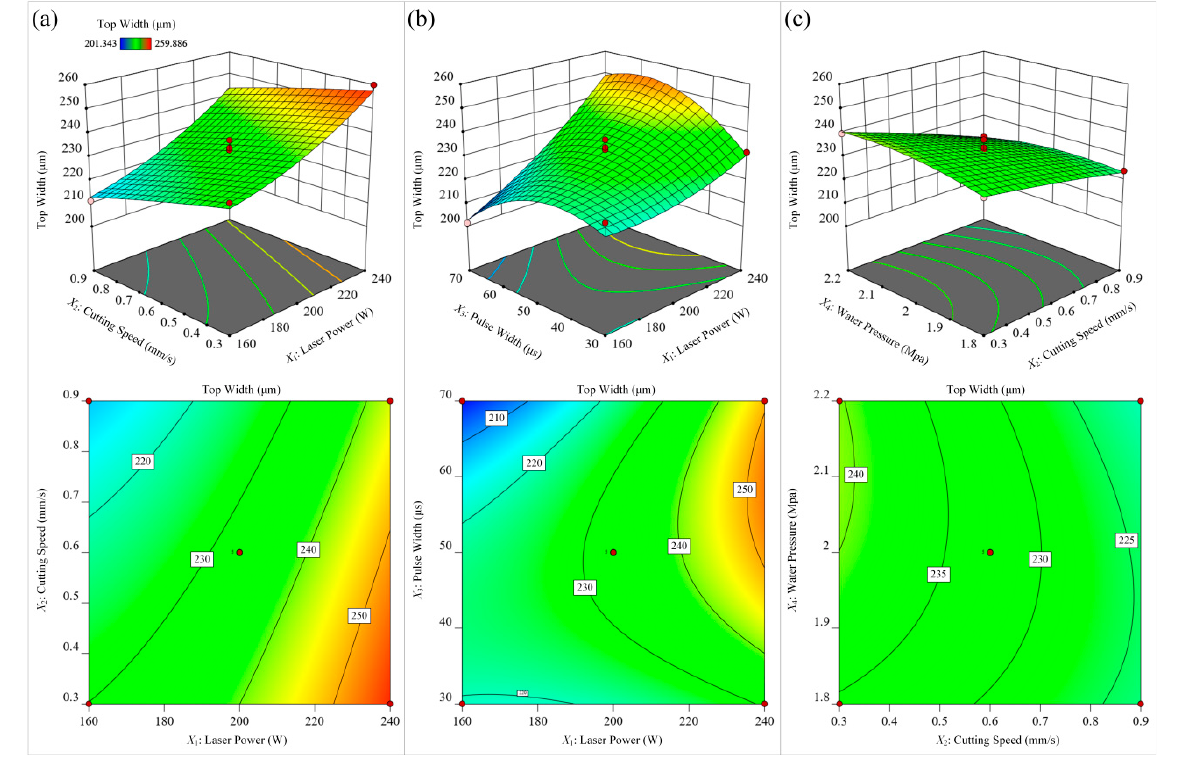
Figure 15. The influence of different process parameters on the width. ( a ) laser power and cutting speed; ( b ) laser power and pulse width; ( c ) cutting speed and water pressure.